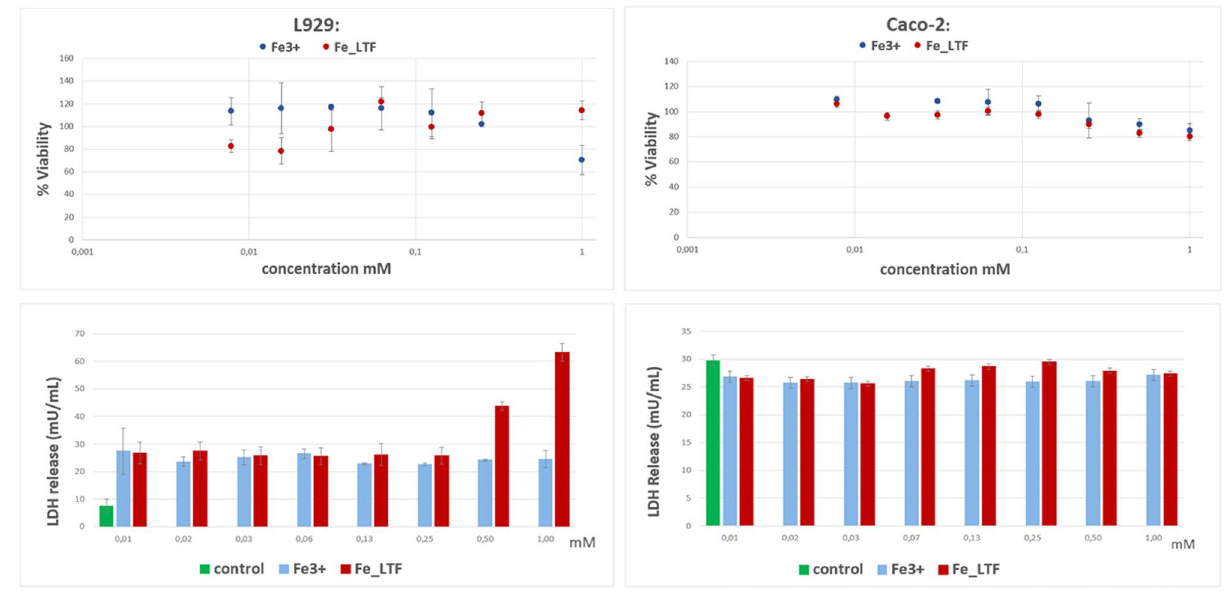
Figure 6. Cytotoxic effect of iron citrate and complex of Fe-bLTF in L929 and Caco-2 cells detected with the MTT reduction assay (values are expressed as a percentage of cell viability) and LDH release assay (values are expressed in